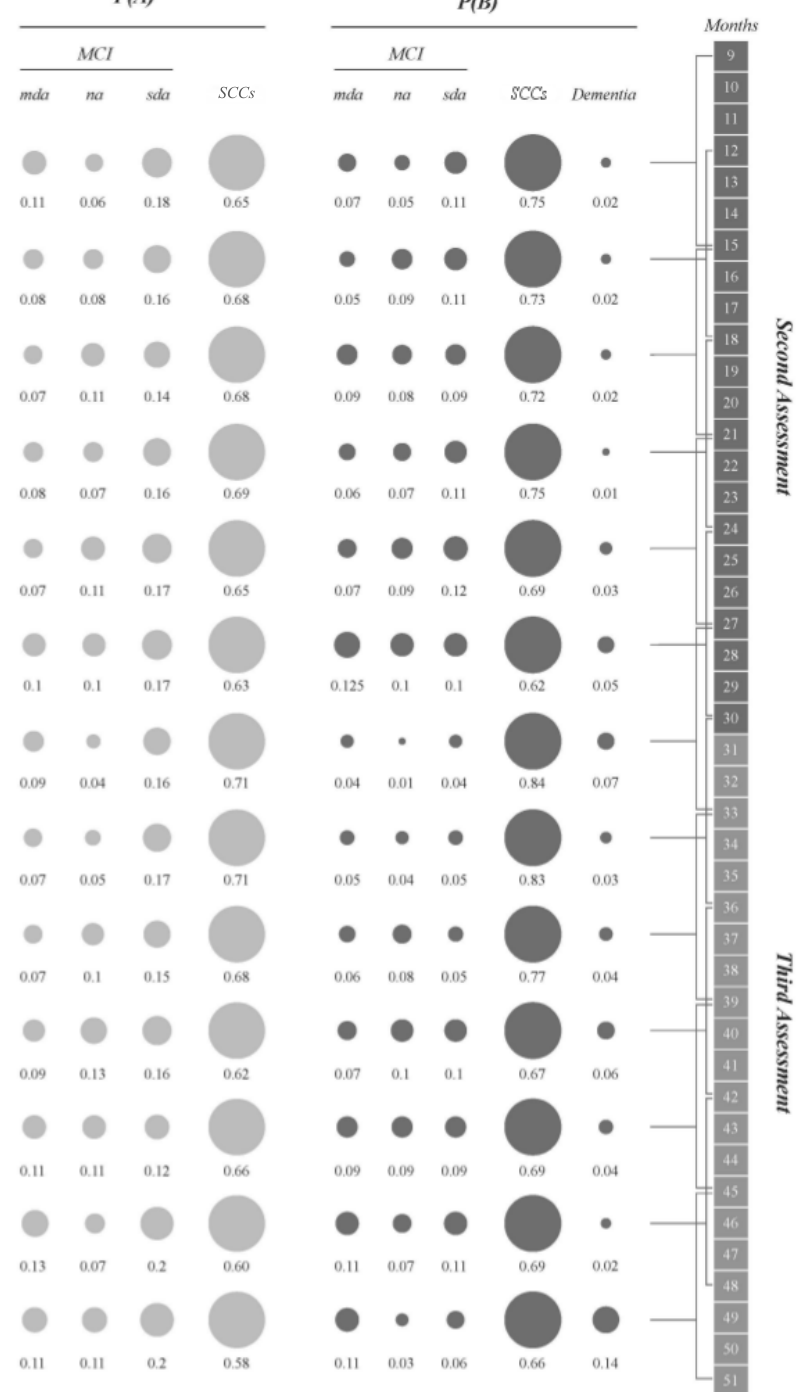
Figure 4. Diagnostic probabilities at baseline P(A) and at follow-up P(B) . Months between baseline and follow-up assessments are represented on the right-hand side of the diagram. Each line represents one time interval, with brackets in the column on the right showing the overlapping nature of the intervals (e.g., time interval 1 is indicated by the bracket encompassing months 9 to 15 and overlaps with interval 2, indicated by the bracket encompassing months 12 to 18). Diagnostic probabilities are represented at baseline in light grey and at follow-up in dark grey. SCCs = subjective cognitive complaints; MCI = mild cognitive impairment; mda = multidomain amnestic; na = non-amnestic; sda = single domain